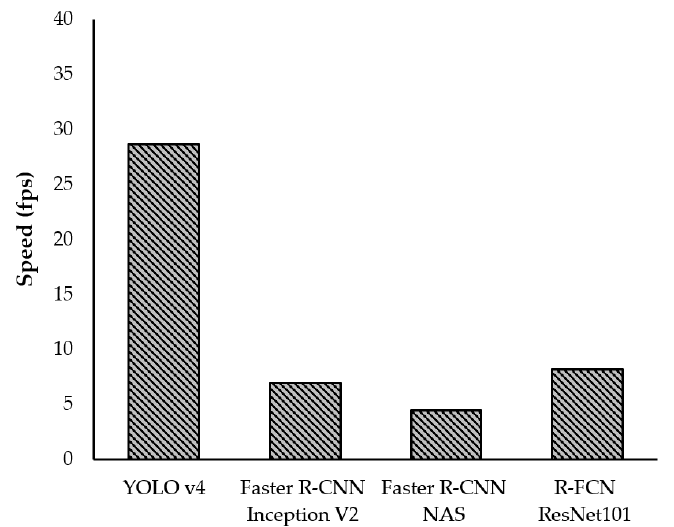
Figure 10. Average detection time of the proposed CNNs for sugar beet damage detection.